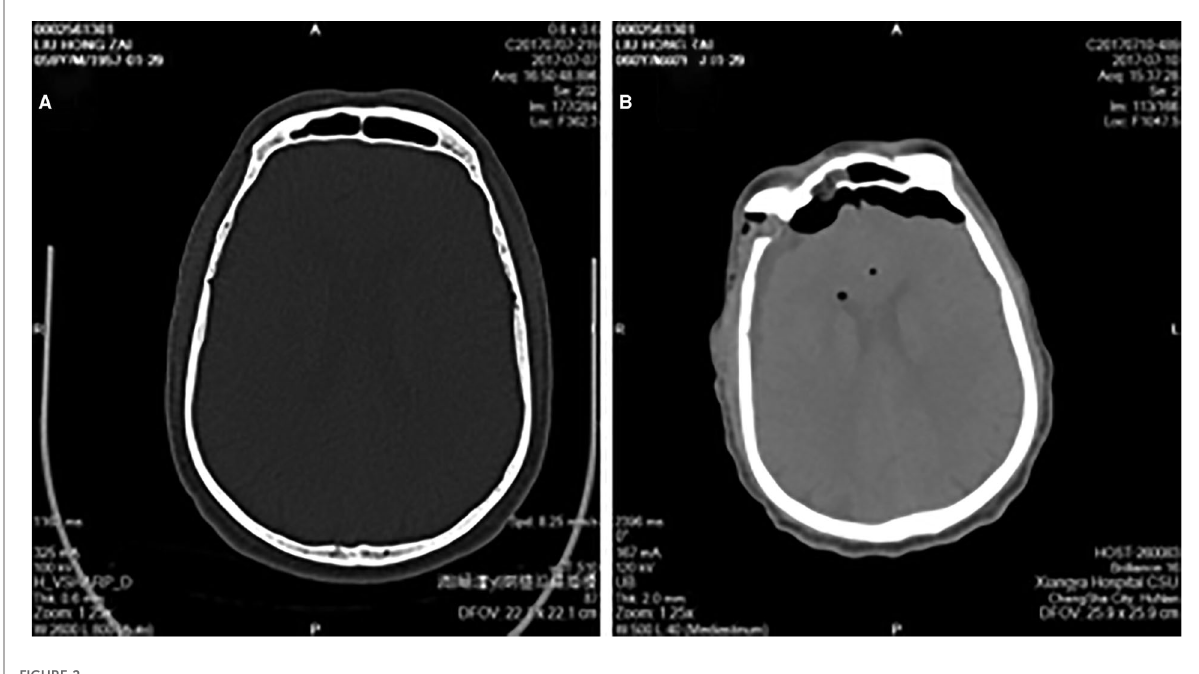
FIGURE 2 Pre- ( A ) and post-operative ( B ) CT scaning at frontal sinus